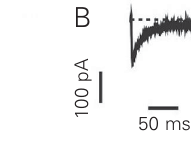
Figure 1. Whole-cell inward Ca 2+ currents evoked by a double- pulse protocol in GH3 neuroen- docrine cells. A , Representative traces in response to step depo- larization to 0 mV for 120 ms